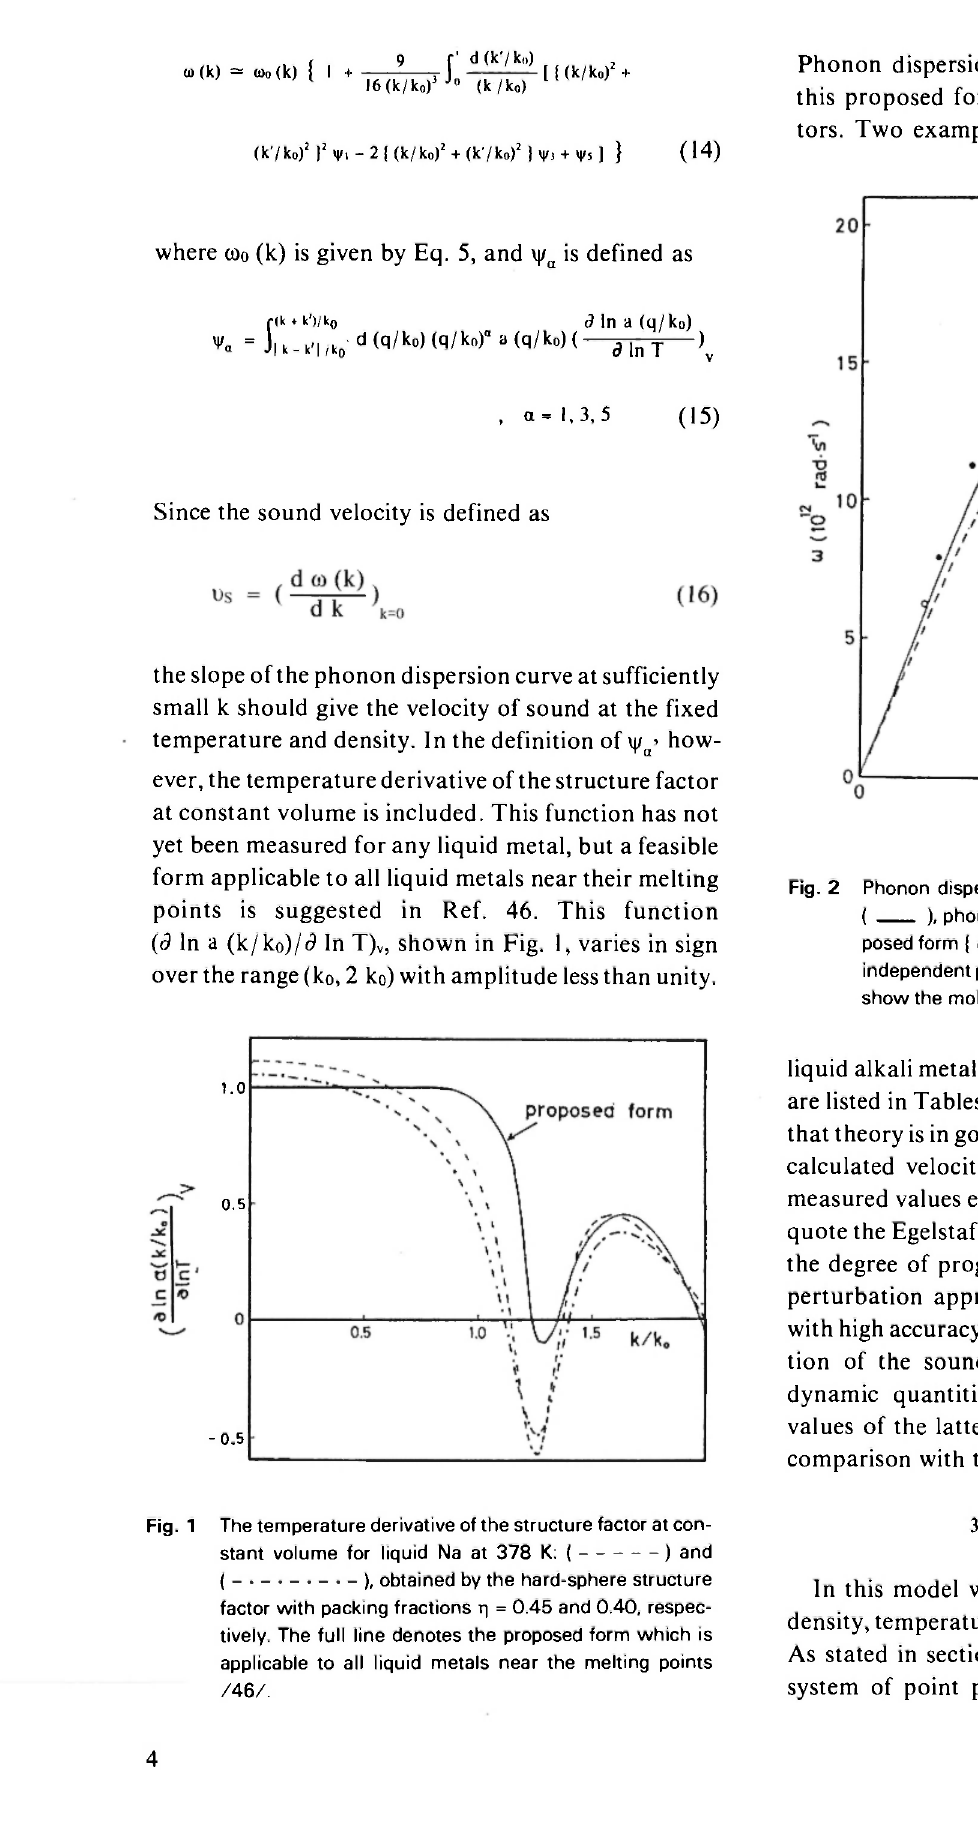
Fig. 1 The temperature derivative of the structure factor at con- stant volume for liquid Na at 378 K: ( ) and ( _ . _ . _ . _ . _ ), obtained by the hard-sphere structure factor with packing fractions η = 0.45 and 0.40, respec- tively. The full line denotes the proposed form which is applicable to all liquid metals near the melting points